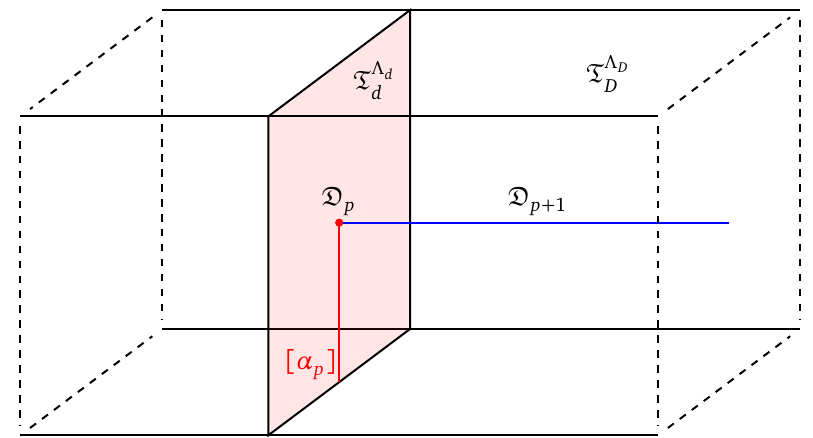
Λ d Figure 15: A “non-genuine” sub-defect D of the absolute defect T arising at p d Λ D the end of a genuine defect D of the absolute theory T . Such a config- p + 1 D = [ D ] ∈ L − Λ uration occurs when the equivalence class α and p p d , p + 1 d , p + 1 [ D ] = π ( α ) ∈ Λ . In such a situation, the non-topological sub-defect D p + 1 p + 1 p D , p + 2 p ] ∈ L / Λ is further attached to a topological sub-defect [ α of the absolute p d , p + 1 d , p + 1 Λ d defect T d